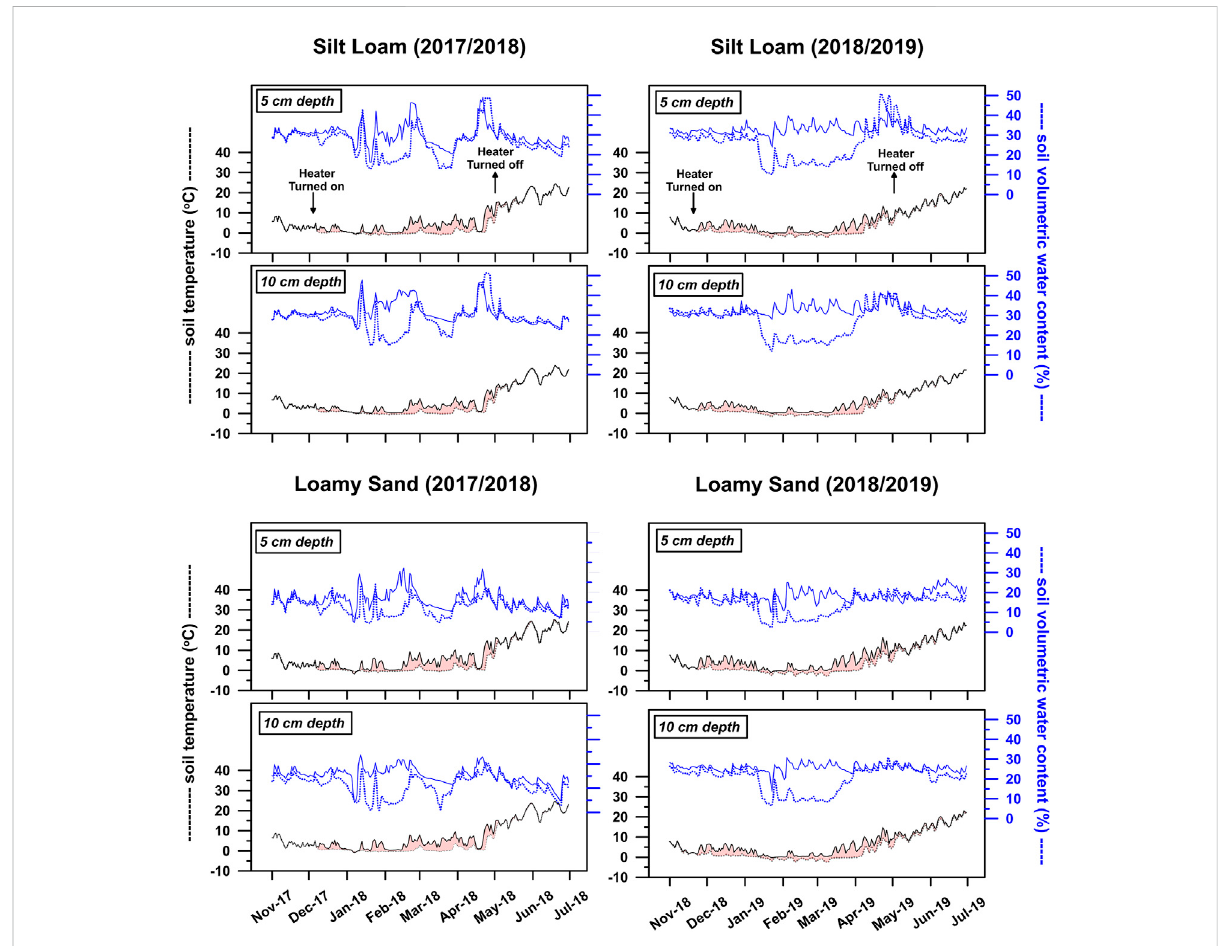
FIGURE 1 Soil temperature and volumetric water content daily averages at 5 and 10 cm depths of the silt loam and loamy sand soils. Solid lines, heated lysimeter; dashed lines, non-heated lysimeter. The red shade illustrates differences in soil temperature between heated and non-heated